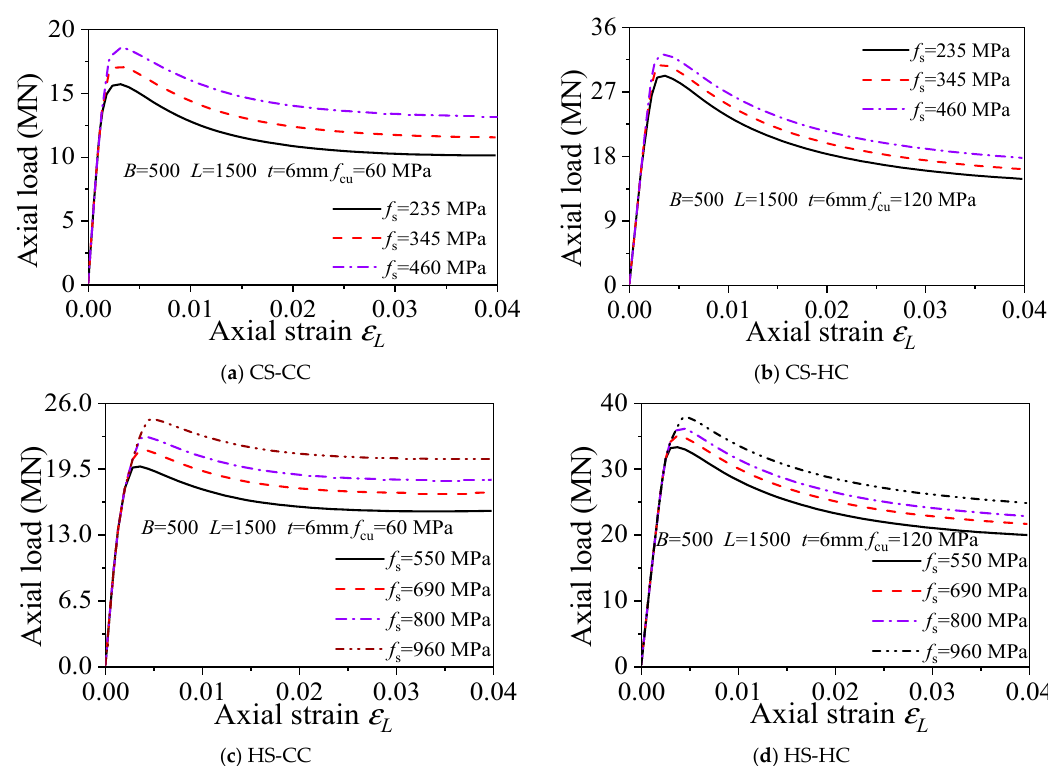
Figure 7. Influence of steel yield strength on the load–strain curve.